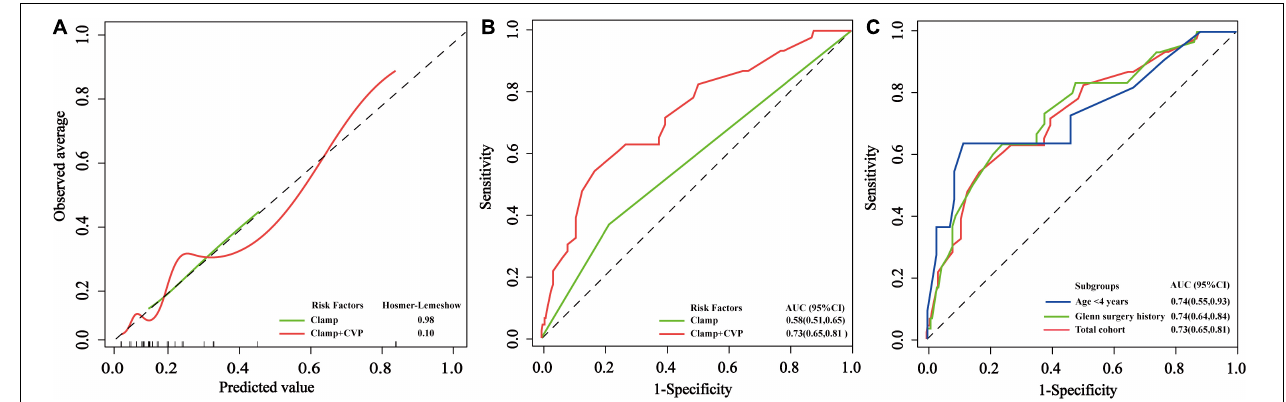
FIGURE 2 | The performance of the logistic regression models for persistent LD. (A) Calibration curves and corresponding p -values from Hosmer–Lemeshow goodness-of-fit test in the total cohort. (B) The receiver operating characteristic curves and their areas under receiver operating curves in the total cohort. (C) The receiver operating characteristic curves were used for evaluating the performance of the persistent LD logistic regression model in the two subgroups with age ≤ 4 years old and prior Glenn’s surgery.